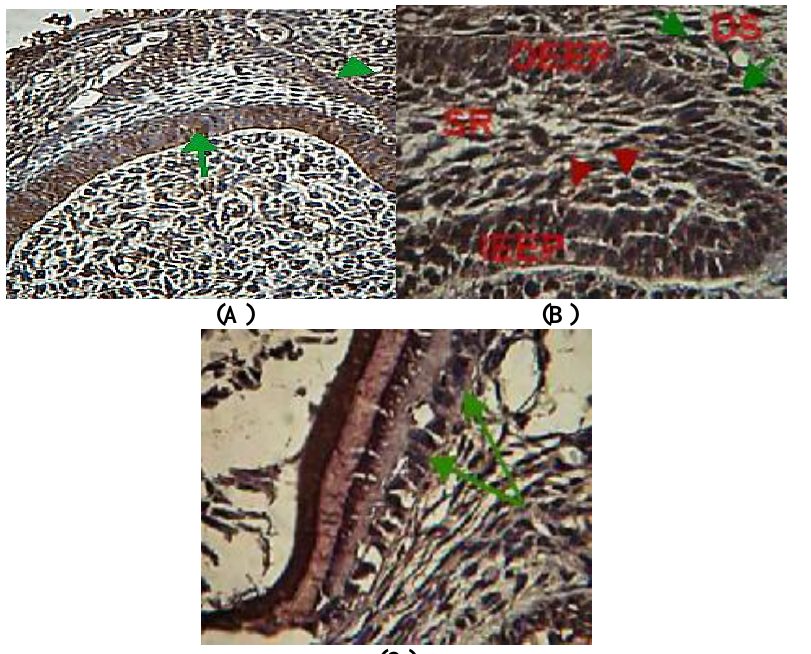
Figure 4: Experimental group with immunohistochemical expression of TGF β 1 (A). At 16th day IUL shows positivity by.Inner enamel epithelial (arrow), outer enamel epithelial (arrow head) (X20).(B) At 18th day IUL shows positivity by Inner enamel epithelial (IEEP), outer enamel epithelial (OEEP), stellate reticulum (SR),stratum intermedium (red arrow heads), mesenchymal cell(green arrows) in dental sac(DS) (X100). (C) one day old, shows positivity by Ameloblast (arrows)